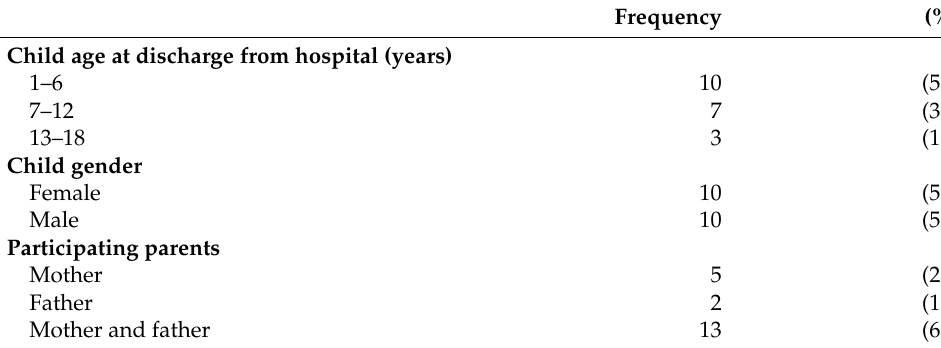
Table 1. Characteristics of included